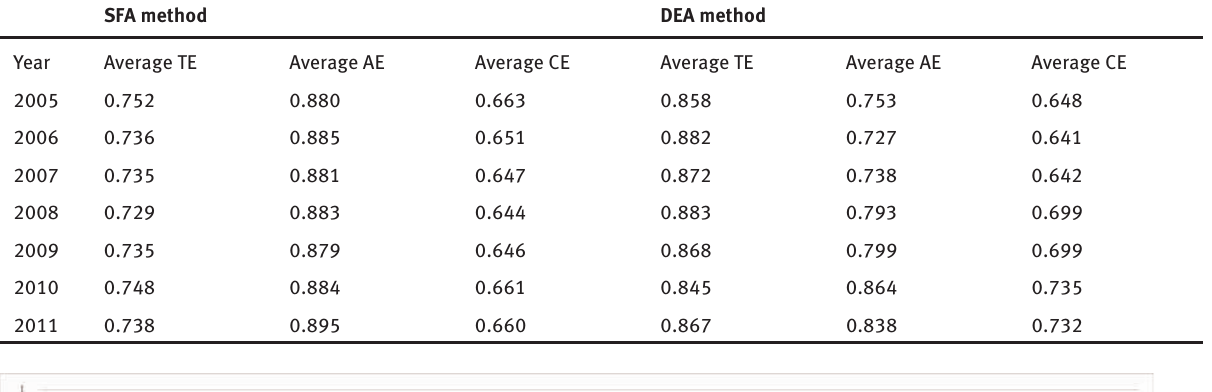
Table 2: Average values of technical, allocative and cost efficiency of general hospitals for each individual year, estimated by the SFA method and DEA